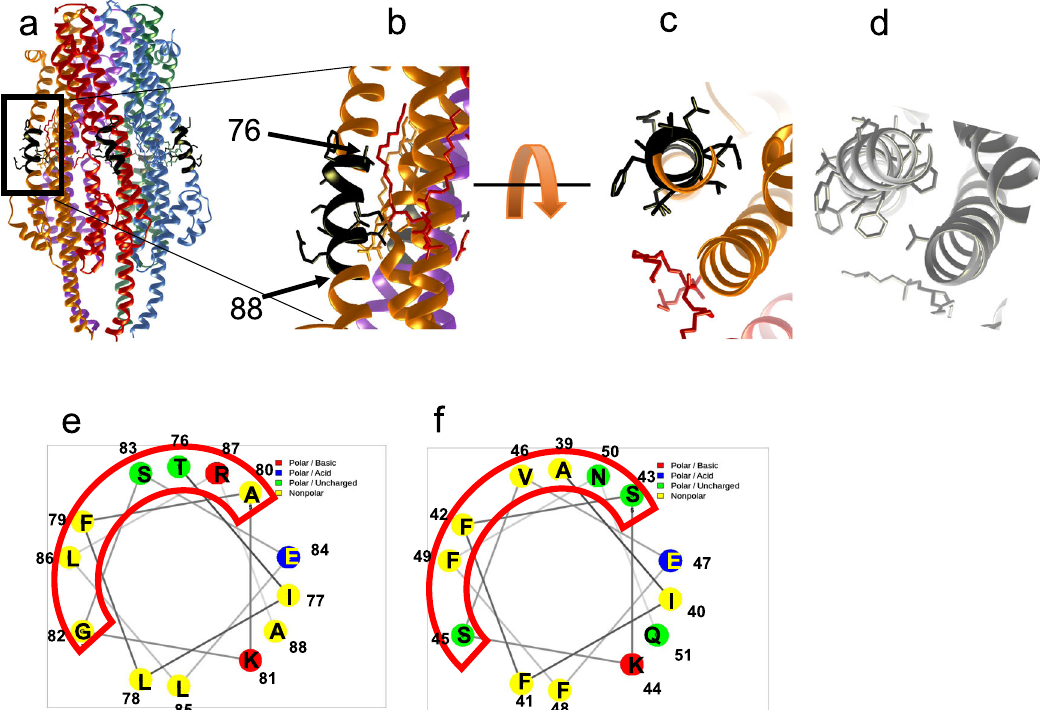
Fig. 9 ExbB α 2 helix: comparison between Sm and Ec. ExbB-ExbD structure with residues 76-88 colored black and showing the amino acid side chains. a general view of the Sm pentamer; ( b ) an enlarged view of ( a ); ( c , d ) two perpendicular close-up views of the exchanged region 76-88 in Sm ( c ) and 39-51 in Ec ( d ). e , f Helical wheel representations of the swapped regions between ExbB Sm and ExbB Ec TM1. e ExbBSm 76-88; f : ExbBEc 39 – 51. The red boxes show the helical face in interaction with the